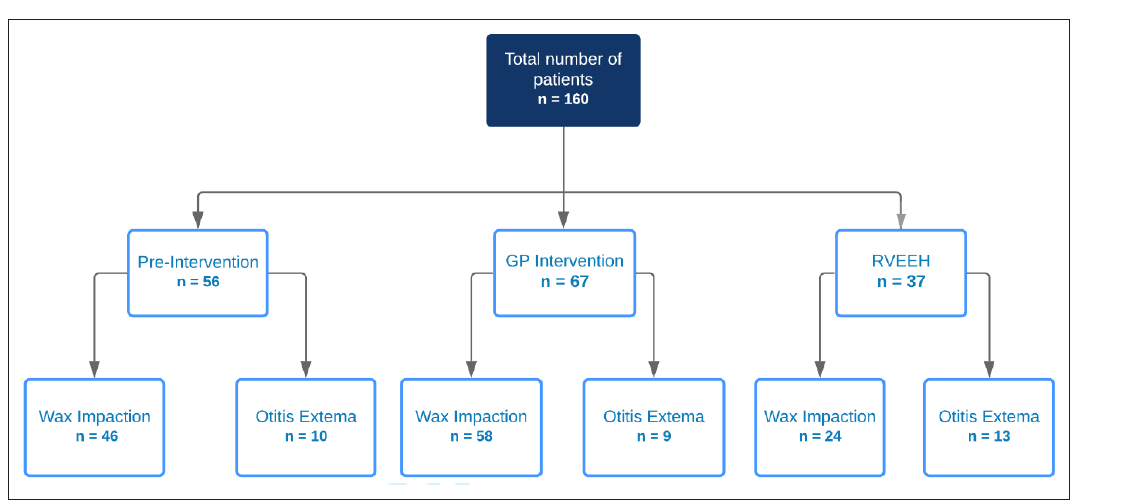
Figure 1 . Number of patients in each of the groups (pre-intervention, intervention, and